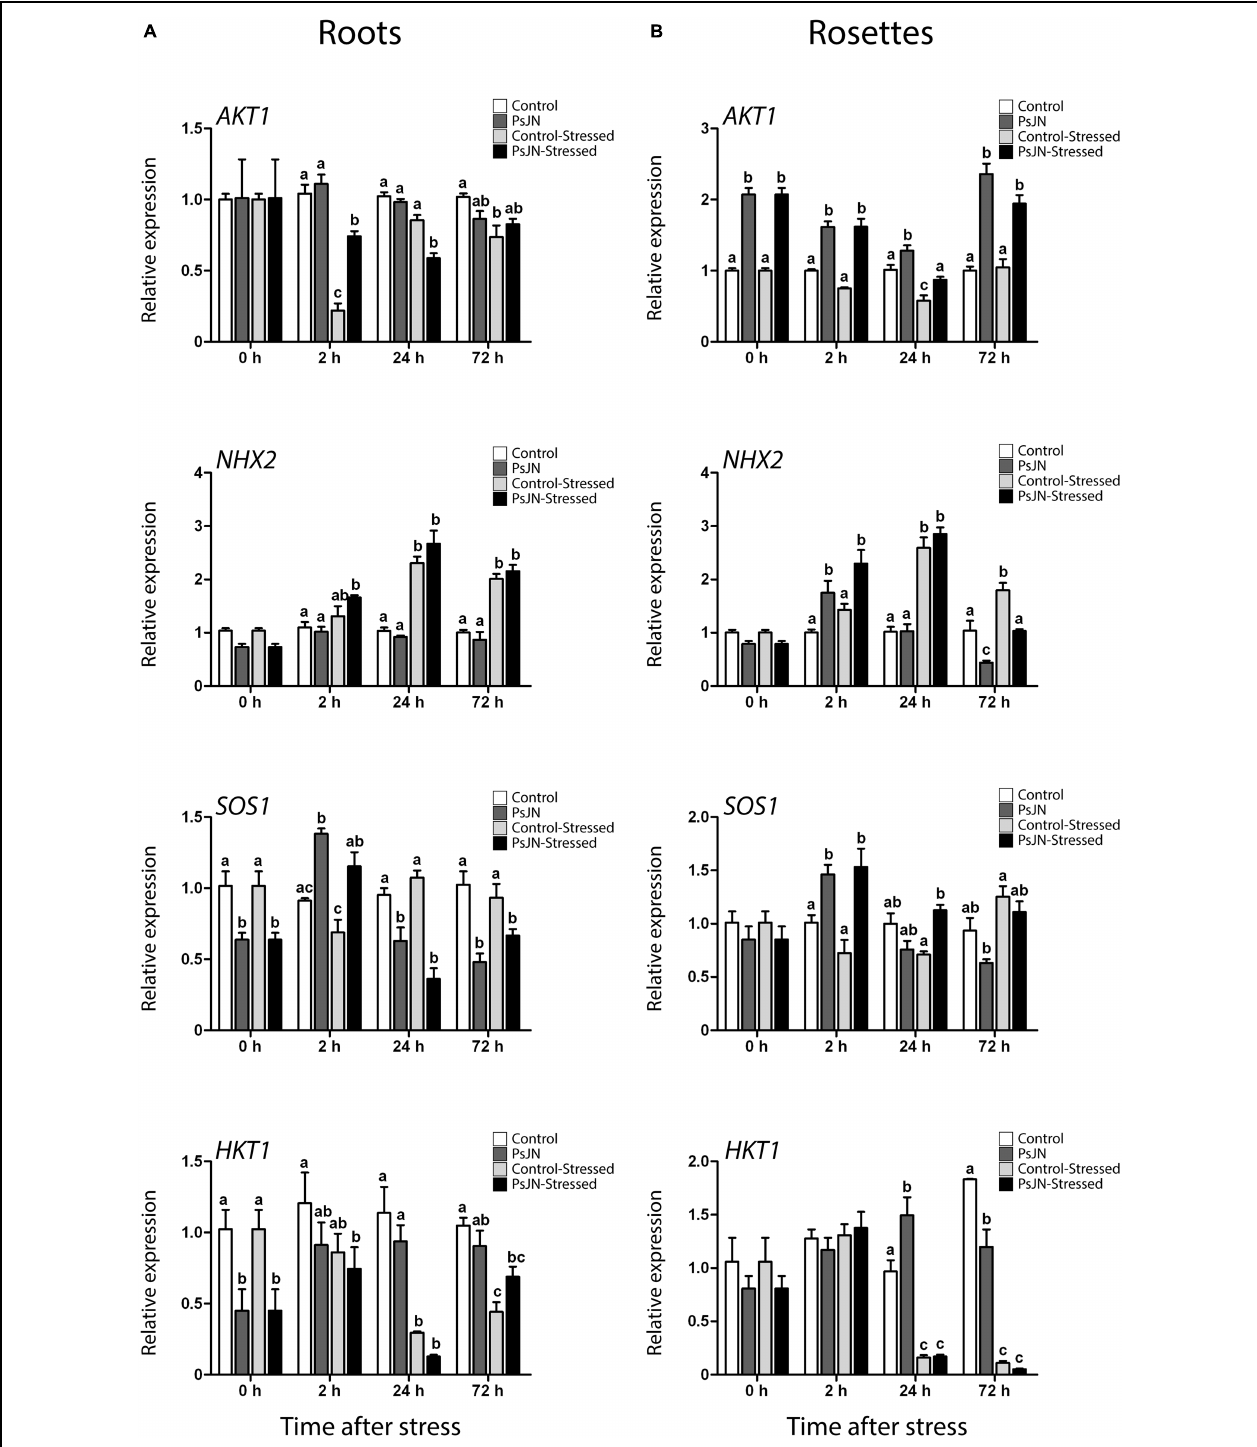
FIGURE 6 | Effect of B. phytofirmans PsJN on A. thaliana ion transporters transcription after short-term exposure to salt stress. Quantitative RT-PCR determinations of relative expression levels of the genes: AKT1 (Arabidopsis K + Transporter 1 ); NHX2 ( Sodium Hydrogen Exchanger 2 ); SOS1 ( Salt Overly Sensitive 1 ); and HKT1 ( High-Affinity K + Transporter 1 ), in roots (A) and rosette (B) of A. thaliana plants treated with or without strain